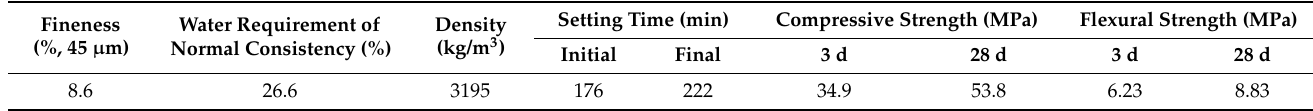
Table 1. Basic physical and mechanical properties of cement.